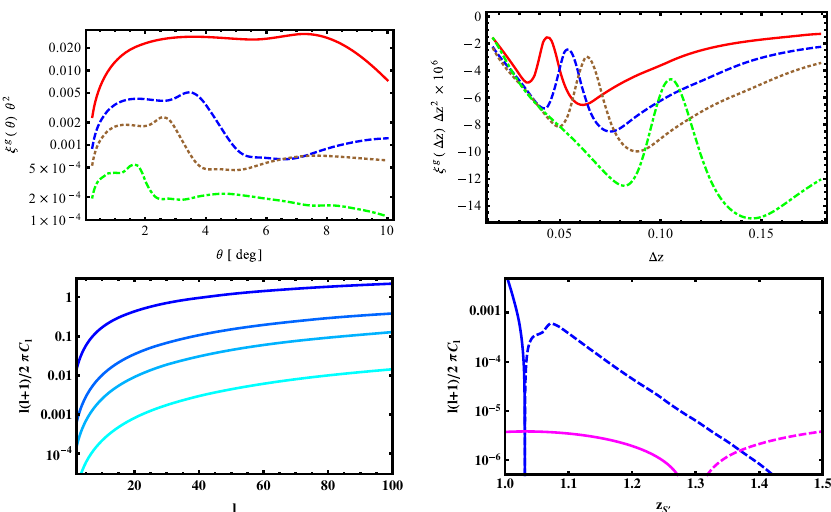
Fig. 14 Top panel: transverse (on the left) and radial (on the right) correlation function at z = 0 . 3 , 0 . 7 , 1 , 3 from top to bottom, respectively. Bottom panel: the transverse power spectra at z = 0 . 1 , 0 . 5 , 1 , 3 from top to bottom, respectively (on the left), and the radial one for (cid:23) = 20 and z 1 = 1 as function of z 2 (on the right). The standard, non-relativistic terms in blue, the relativistic corrections from lensing in magenta. Images reproduced with permission from [top] (Montanari and Durrer 2012), and [bottom] from Bonvin and Durrer (2011), copyright by